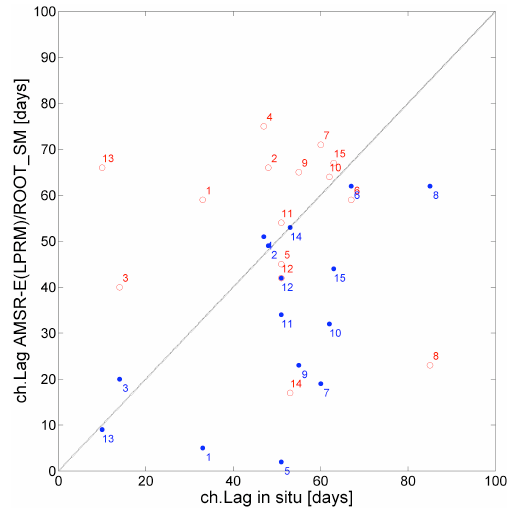
Fig. 5. Anomaly autocorrelation for the Deciduous broadleaf forest site Hainich in Germany. Black dashed horizontal line in autocor- relation graph indicate where the rk value is equal to 1/ e , indicating the characteristic lag-time at the x-axis, and where the rk value is equal to 0, indicating at which lag (x-axis) the autocorrelation has been lost.